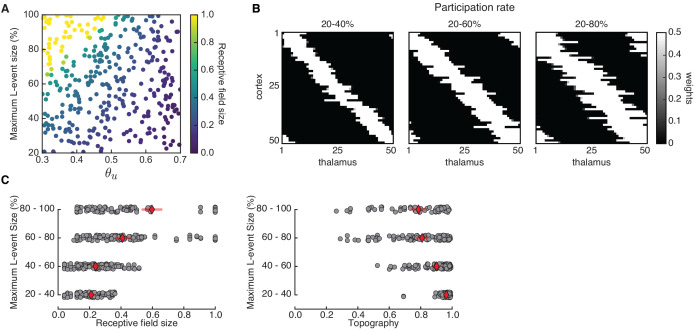
Receptive field refinement depends on the properties of L-events.(A) Receptive field sizes from 500 Monte Carlo simulations for different sizes of L-events where the minimum participation rate was 20%, and the maximum participation rate was varied. The input threshold was taken from the range 0.3≤θu≤0.7, while the adaptive H-events had a fixed inter-event-interval Hint=3.5. (B) Individual receptive fields for different L-event maximum participation rates and θu=0.50. As the upper bound of the participation rate progressively increases from 40% to 80%, receptive fields get larger. (C) Left: Receptive field sizes from A binned according to the maximum L-event size. Right: Corresponding topography of selective receptive fields for different sizes of L-events. Diamonds in red indicate the mean, while horizontal bars indicate the 95% confidence interval.